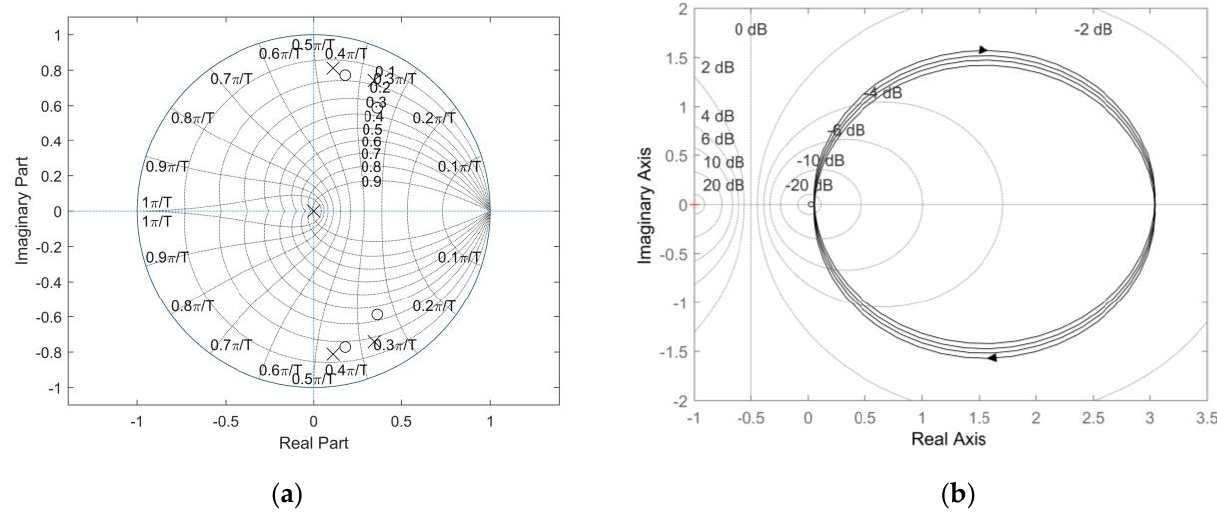
Figure 7 is the pole-zero diagram and the Nyquist diagram, respectively.